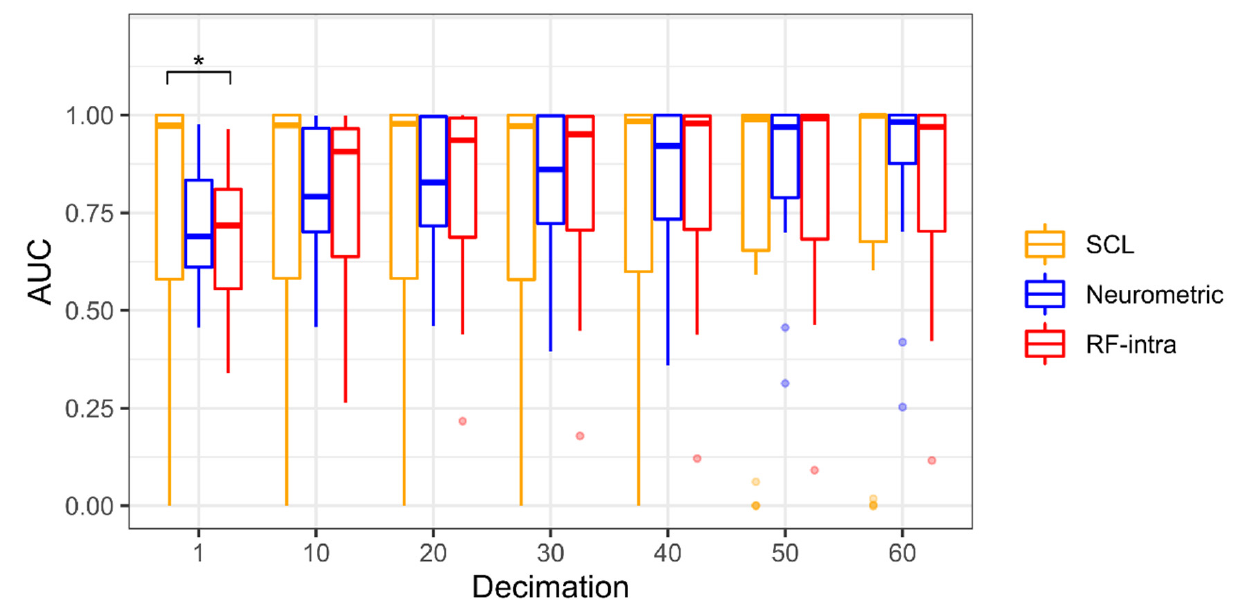
Figure 4. Boxplot representation of Area Under Curve (AUC) for seven different decimations (1 to 60 by 10 s step) of the multitasking experiment. The Random Forest (RF-intra) is represented in red, the Neurometric in blue, and the Skin Conductance Level (SCL) in orange. The points represent the outliers, and the asterisk shows that p < 0.05 resulting from the Dunn’s post-hoc tests. Table 1. Measures of dispersion of the AUC values obtained from the laboratory experiment. Values of interquartile range have been reported for each decimation and each variable. Decimation